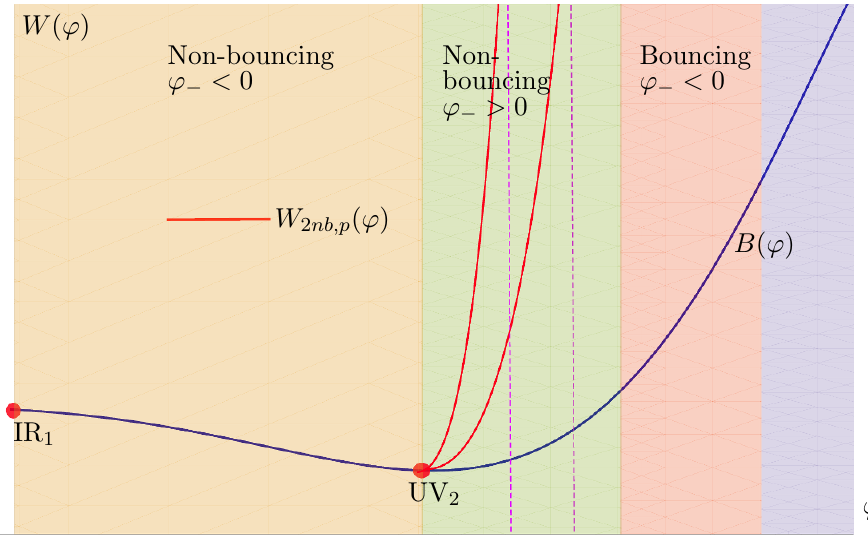
Figure 29. Two non-bouncing (cid:13)ows W 2 nb;p ( ’ ) from UV 2 with identical value of R . Interestingly, (cid:13)ows of this type only exist for R > R min , i.e. when the dimensionless curvature is larger than some minimal value. As a result, such (cid:13)ows do not come from a curvature deformation of a R = 0 (cid:13)ow.